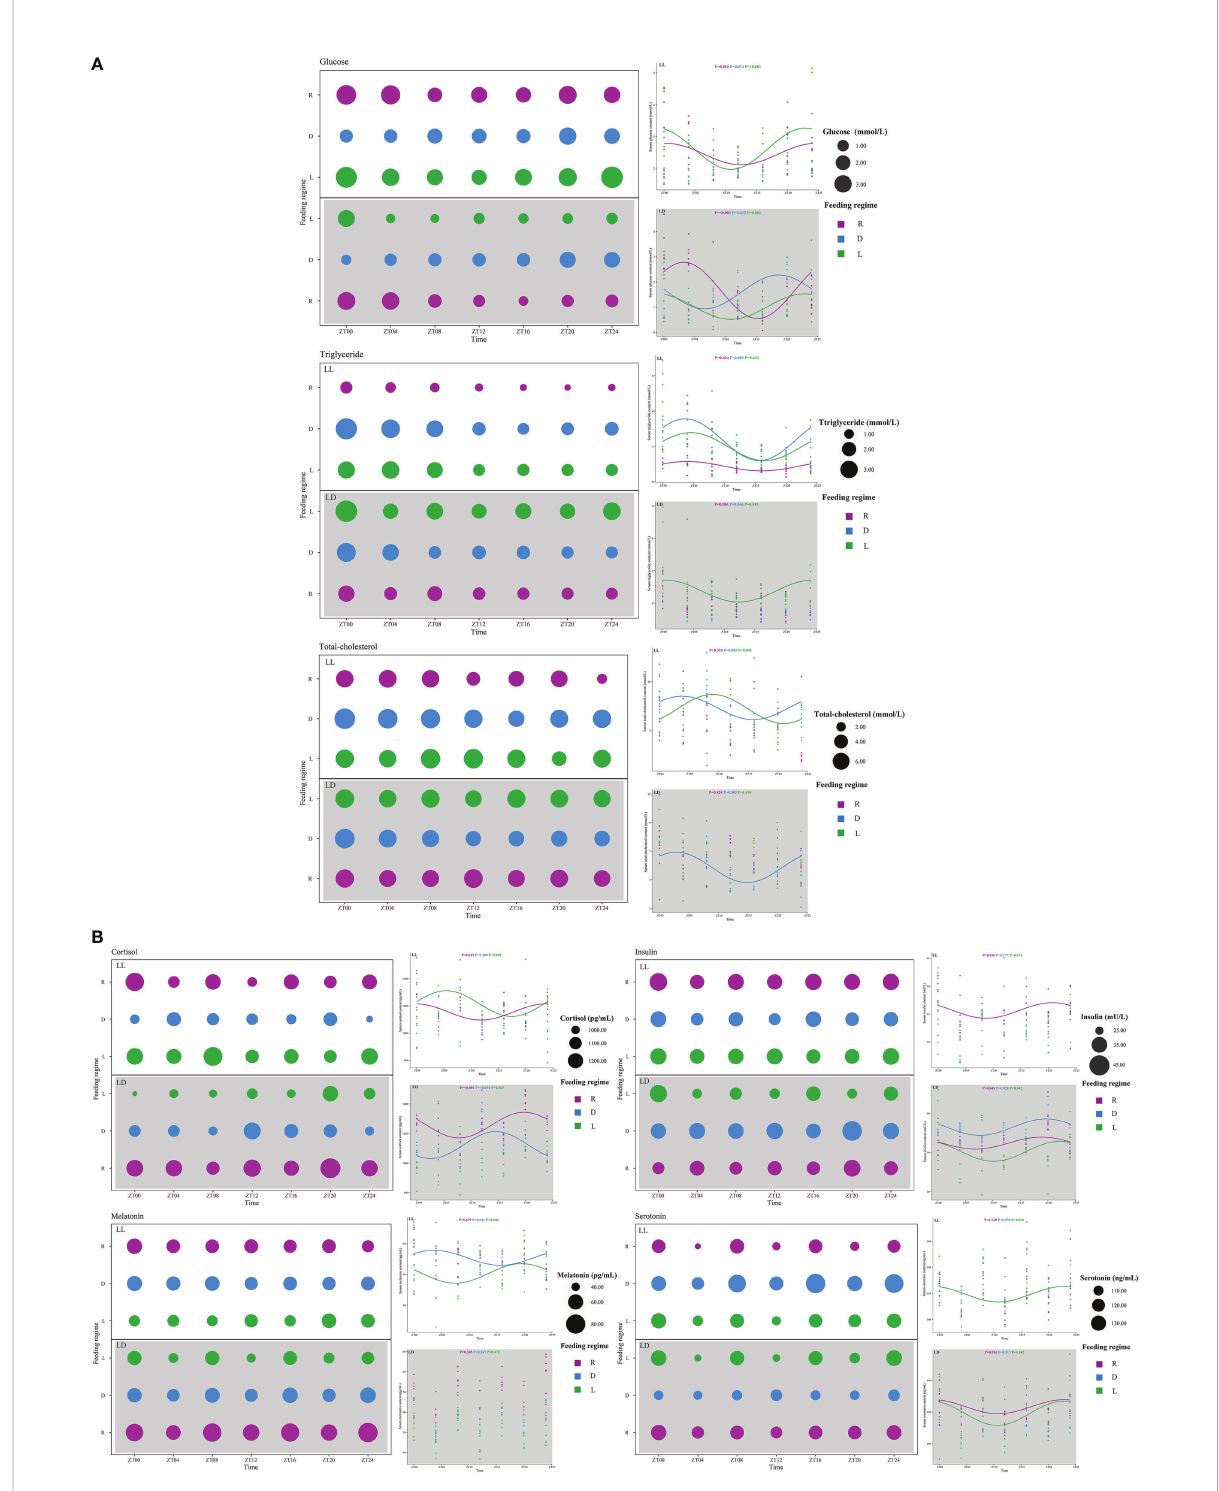
FIGURE 4 Serum metabolites (A) and hormones (B) of juvenile Oncorhynchus mykiss under different experimental treatment. The cosine curve denotes the presence of rhythmic oscillations ( P <